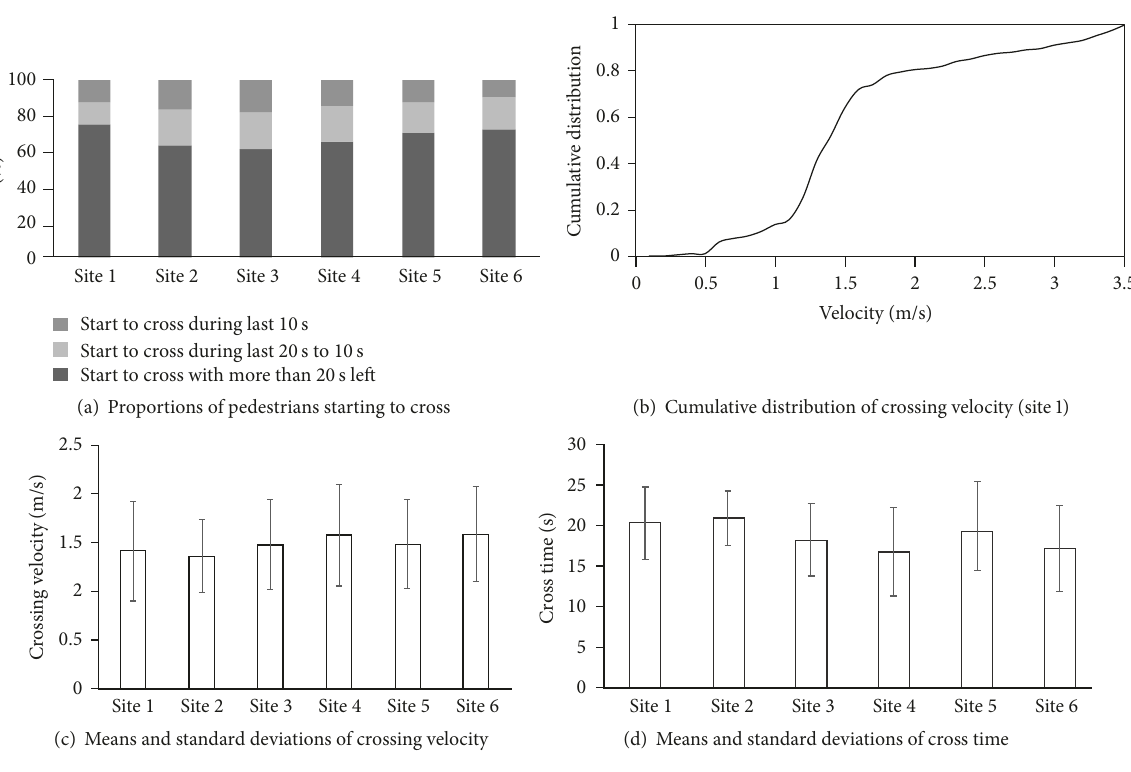
Figure 2: Observed pedestrian movement